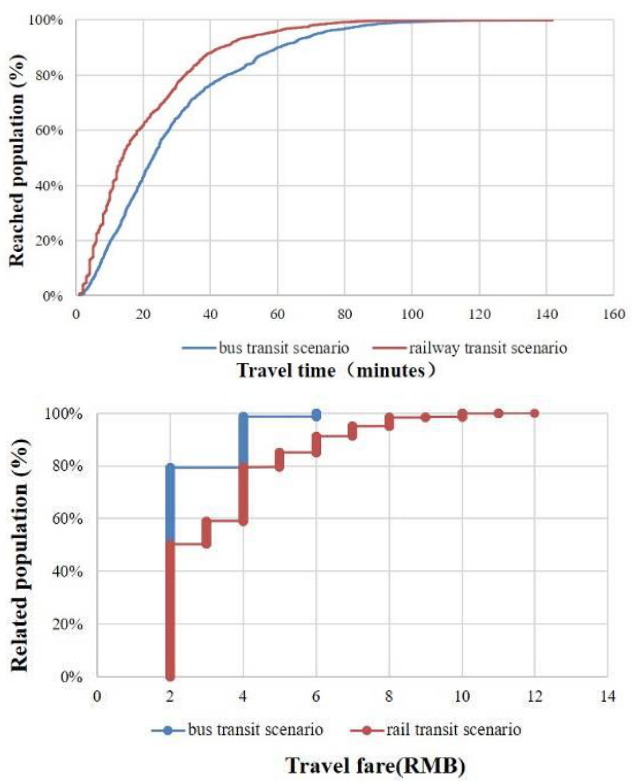
Figure 6. Cumulative share of the population accessing the closest urban commercial complex within a certain travel time and fare cost.